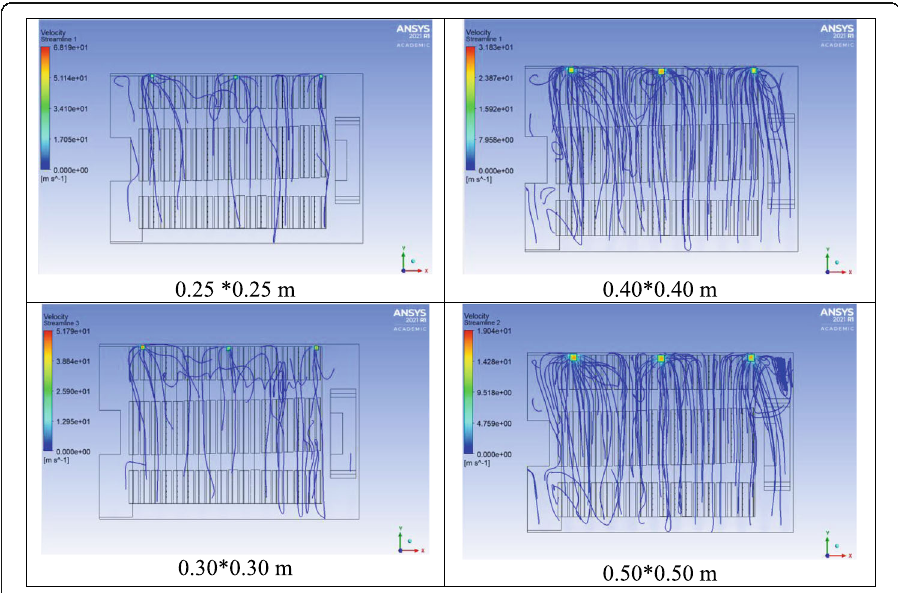
Fig. 10 Stream line air velocity for cross-section square at the breathing level zone (1.2 m), output from the ANSYS CFD model